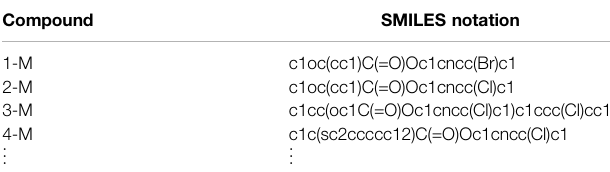
TABLE 1 | The simpli fi ed molecular-input line-entry system (SMILES) of main protease (Mpro) inhibitors and papain-like protease (PLpro)